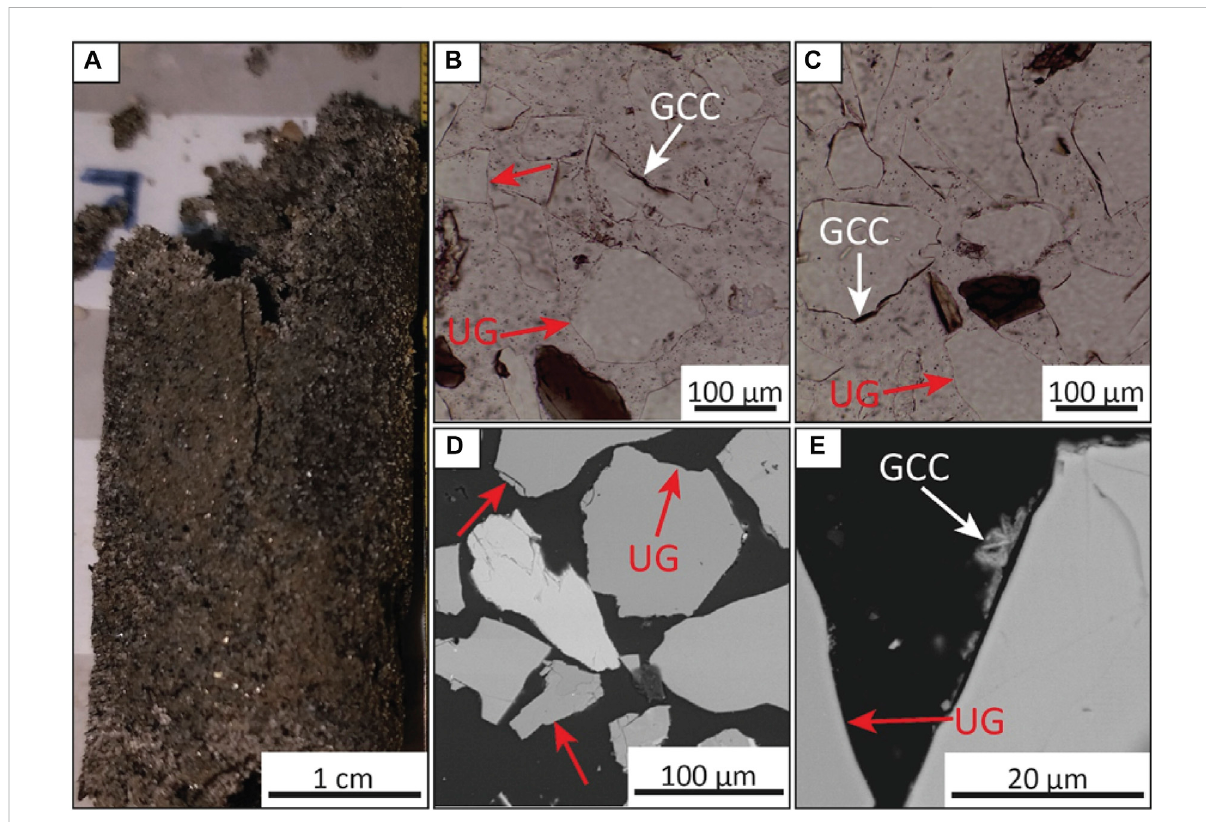
FIGURE 2 Images of samples from Station 028A. (A) Syringe core image of the proximal submarine channel from Station 028A. (B,C) Thin-section photomicrographs showing uncoated grains (UG; red arrows) and grain-coating chlorite (GCC; white arrows) in Sample 1. (D) BSE image showing uncoated detrital grains (Sample 1). (E) BSE image showing an uncoated grain (UG) and discontinuous, detrital grain-coating chlorite in Sample 1. (BSE, Backscattered